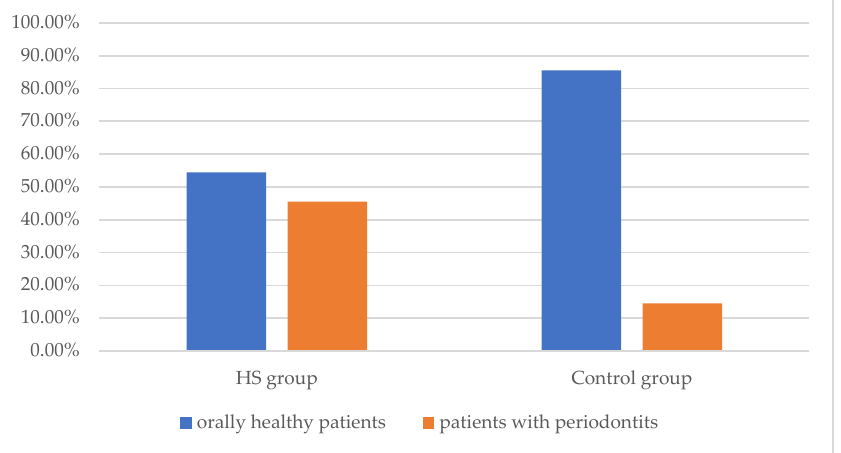
Figure 1. Prevalence of periodontitis in HS and control groups. p < 0.001, HS: hidradenitis suppurativa. Table 2. Staging and grading of periodontitis in HS and control groups. Figure 2 exposes the average copy ‐ count numbers of total bacteria in both groups. The statistically significant higher values were found in HS patients (2.8 × 10 8 average total bacteria count) compared to healthy controls (1.6 × 10 8 average total bacteria count) ( p < 0.05).